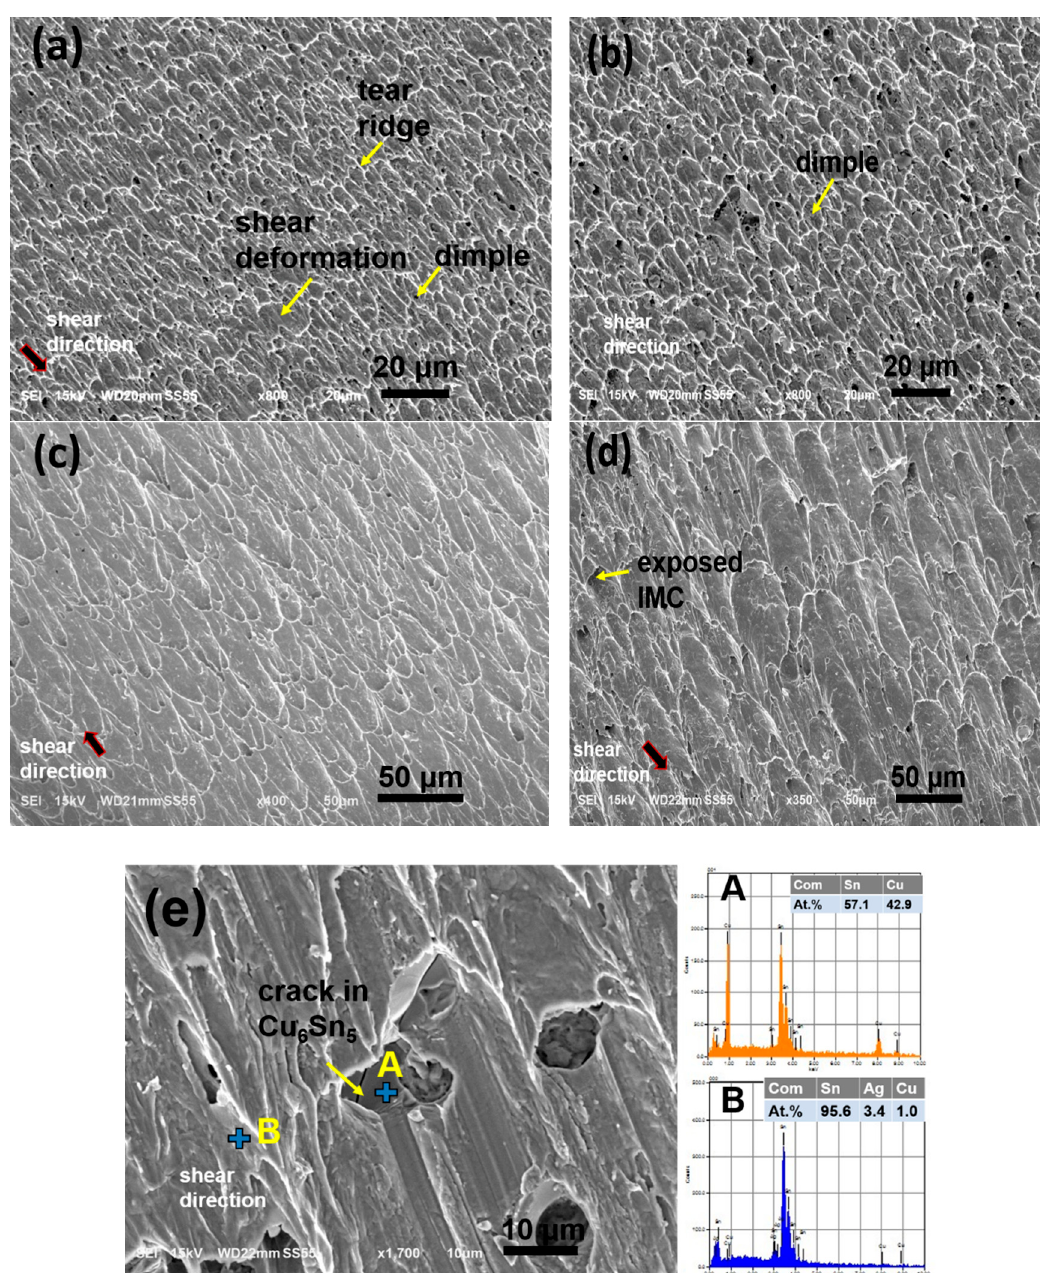
Figure 9. Fractured surfaces of ( a ) as-reflowed and ( b – e ) isothermally aged SAC 305-ZrO2A/Cu joint for various aging time: ( b ) 48 h, ( c ) 144 h, ( d , e ) 256 h, A, B are the EDS analysis corresponding to the points A and B in figure (e).